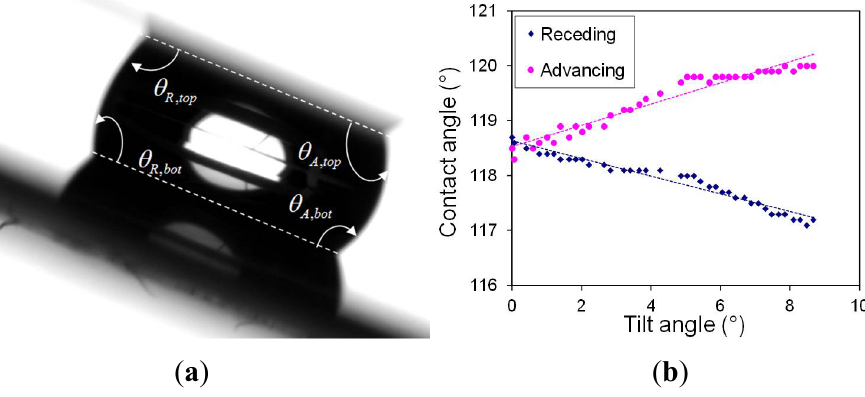
Figure 2. Picture of the confined droplet between two Teflon coated surfaces during a tilt test ( a ). Evolution of the advancing and receding contact angle as a function of the tilt angle ( b ).